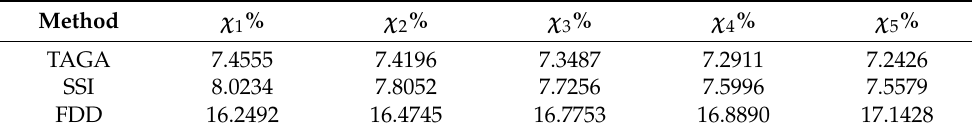
Table 10. Discrepancy between the estimated structural responses and the exact ones for the 5DoF system.